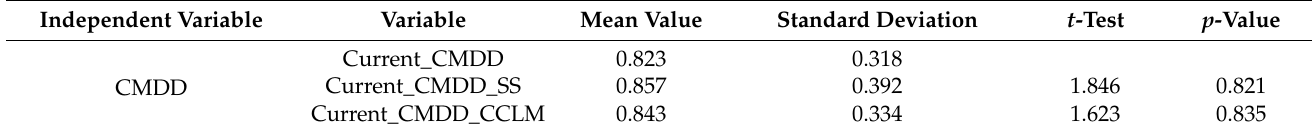
Table 6. Results of t-test of CCLM and GMBOSS